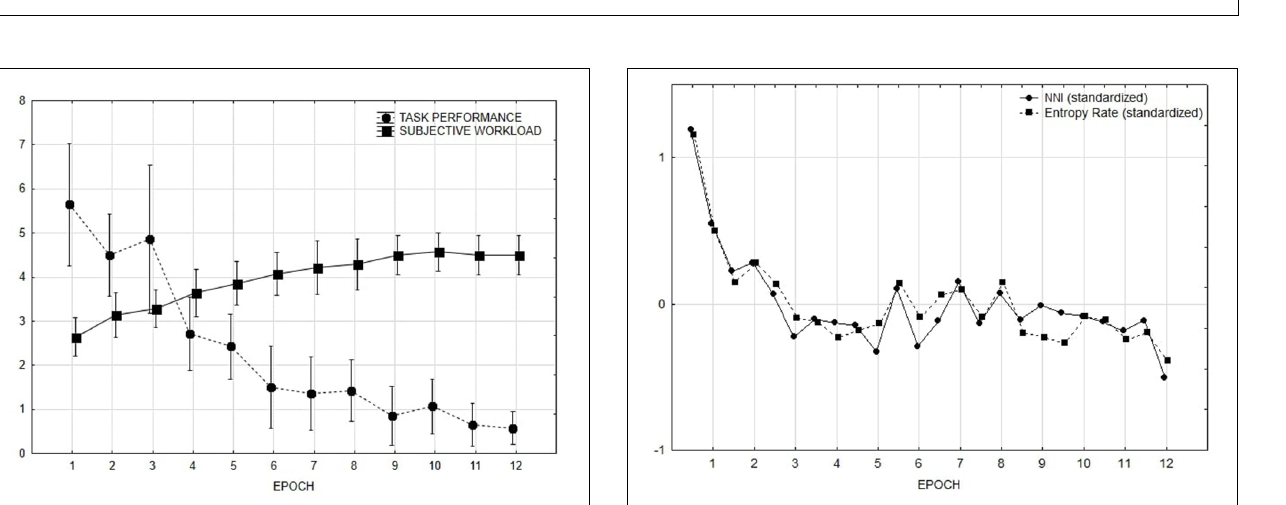
FIGURE 7 | Right panel. Modified version of the original artwork with 35 differences.